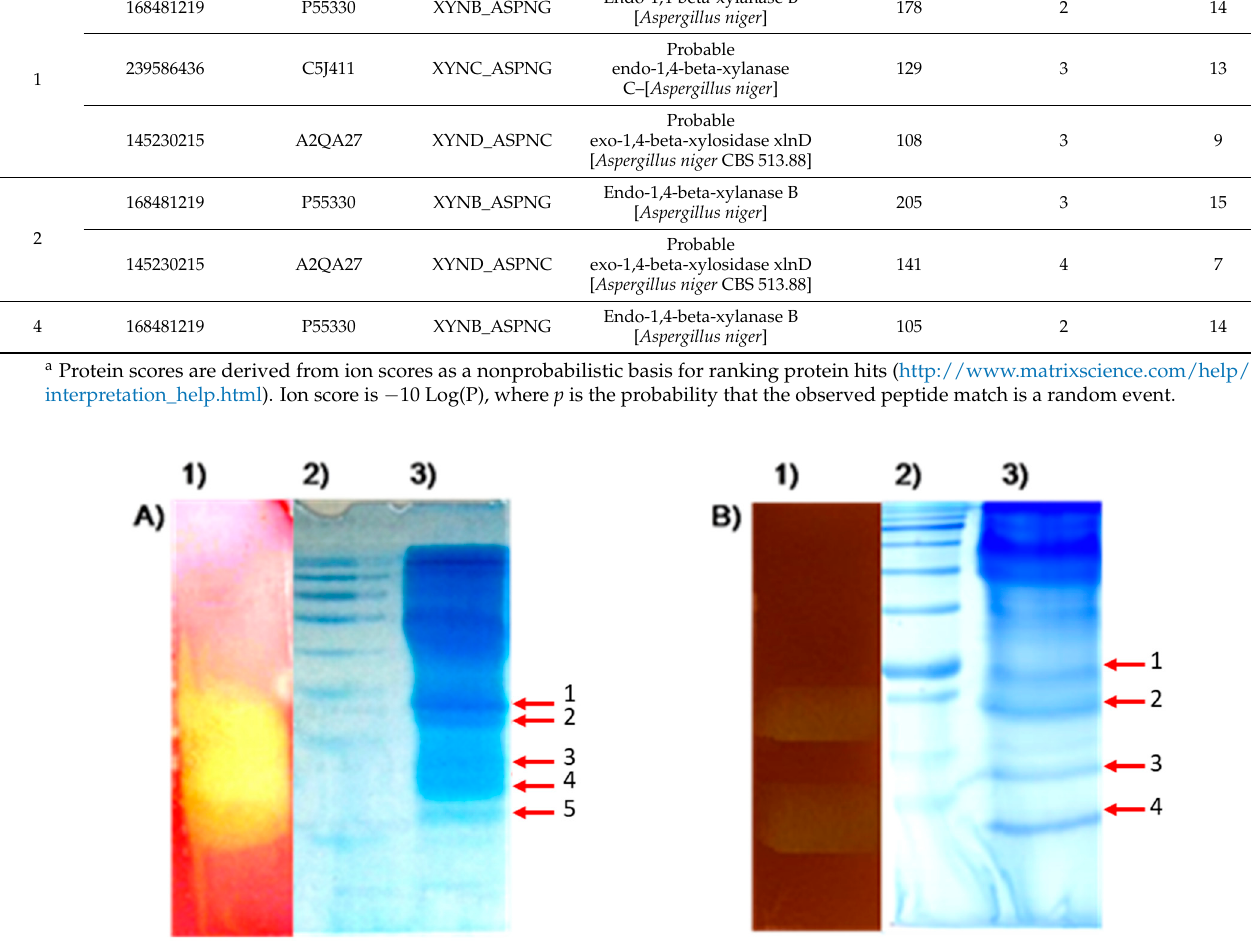
Figure 7. Protein fractionation on semi-denaturing gel of supernatants of Aspergillus niger LPB-334 strain. Semi-denaturing SDS-PAGEs (12.5 %) of Aspergillus niger LPB-334 extracts without denaturating and reducing treatments: zymograms of cellulase activity ( A , lane 1) and xylanase activity ( B , lane 1) were aligned to corresponding lanes stained by Coomassie Blue ( A , B , lane 3) to cut protein bands as labeled by arrows. Zymogram analysis for cellulase and xylanase detection was carried out on agar plate with 1% CMC and 1% xylan, respectively, and stained with Congo Red; panel ( A , B ) lane 2: protein molecular weight marker; panel ( A , B ) lane 3: 80 μ g of total protein. Putative cellulases and xylanases identified in each gel band are listed in Tables 3 and 4, respectively. Table 3. Cellulase identified in the supernatant of Aspergillus niger LPB-334 strain. Bands were selected on the basis of zymograms as shown in Figure 7 and excised from the gel, in situ digested with trypsin and the resulting peptide mixtures were analyzed by LC-MS/MS. Band number corresponds to the band selected on the gel. Raw data were used to query the NCBI database with the taxonomic restriction to fungi as described in detail in the Materials and Methods section. Only proteins identified with two or more peptides were considered as confidently identified. Only proteins that have been annotated in the database as being involved in cellulose metabolism have been reported.